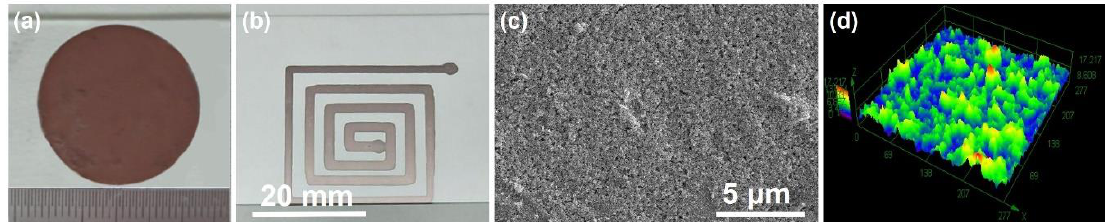
Figure 7. ( a ) A copper film and ( b ) an interconnect wire printed by the optimized single-run direct-writing procedure. Metallic luster of the interconnect wire could be clearly seen in ( b ) from the corresponding view angle. ( c ) A typical SEM image and ( d ) a 3D optical image of the top surface layer of the interconnect wire shown in (b).